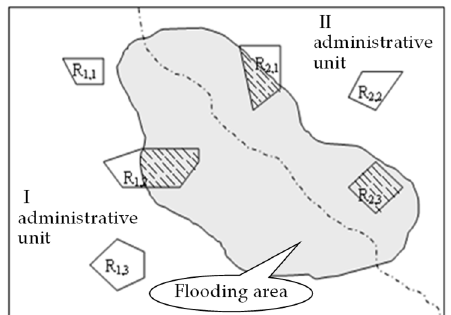
Figure 5. Diagram of flooded residential areas (the residential lands R 1,2 and R 2,1 are partially flooded, and the residential land R 2,3 is completely